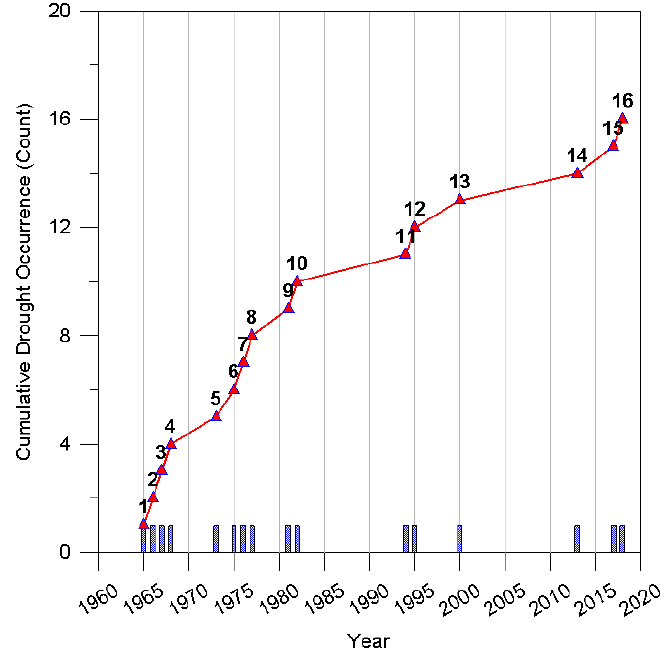
Figure 4. Status of drought damage in Gyeongsangnamdo by year.